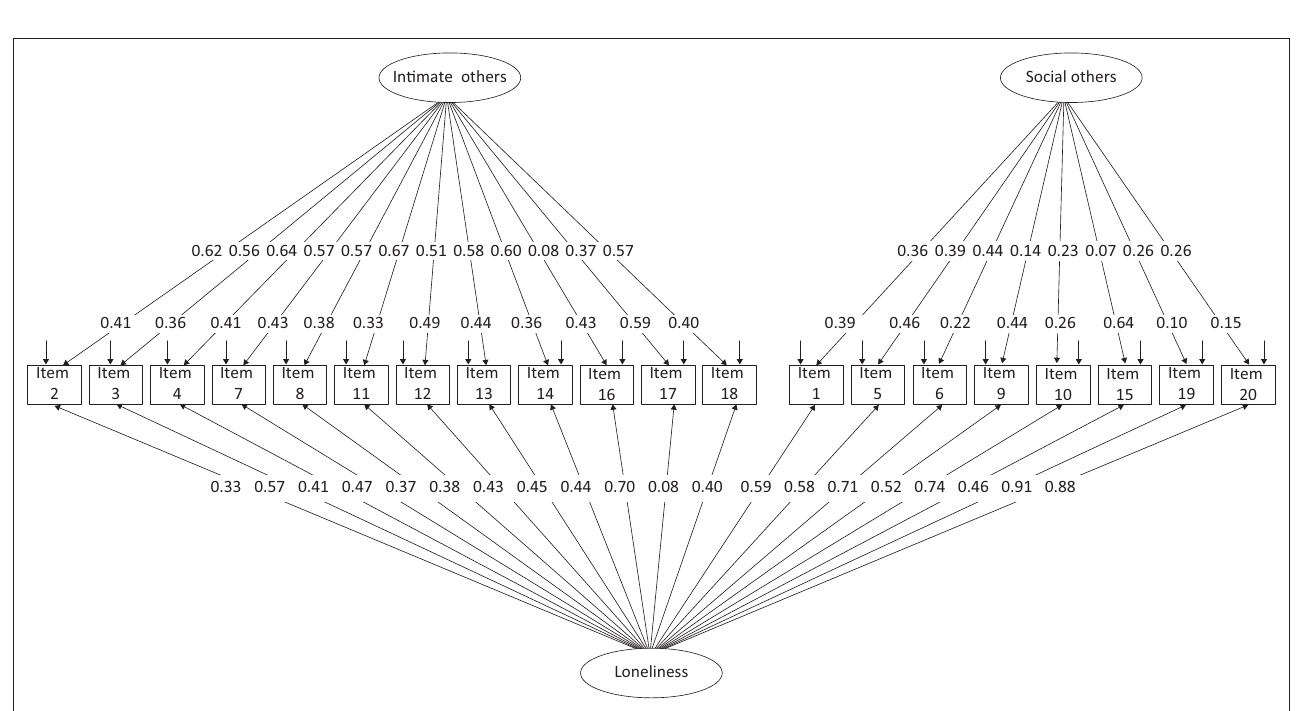
FIGURE 2: Correlated three-factor